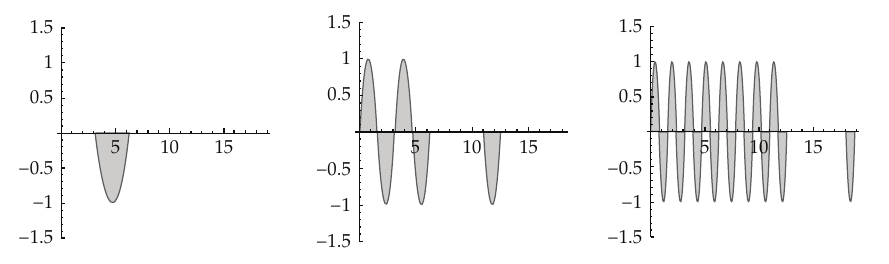
Figure 1: Functions f 1 (cid:2) x (cid:3) , f 2 (cid:2) x (cid:3) , and f 3 (cid:2) x (cid:3) in Example